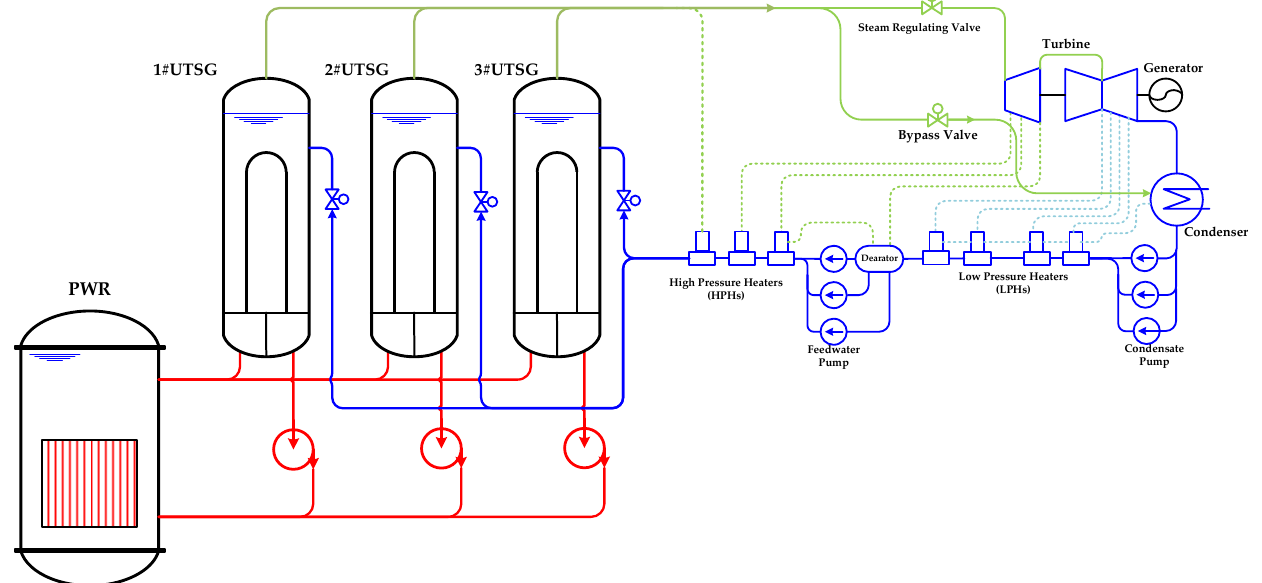
Figure 1. Schematic diagram of a single-modular PWR plant, UTSG: U-tube steam generator. The red lines denote the primary coolant, the blue lines denote the secondary coolant in liquid state, and the green lines denotes the secondary coolant in steam state.